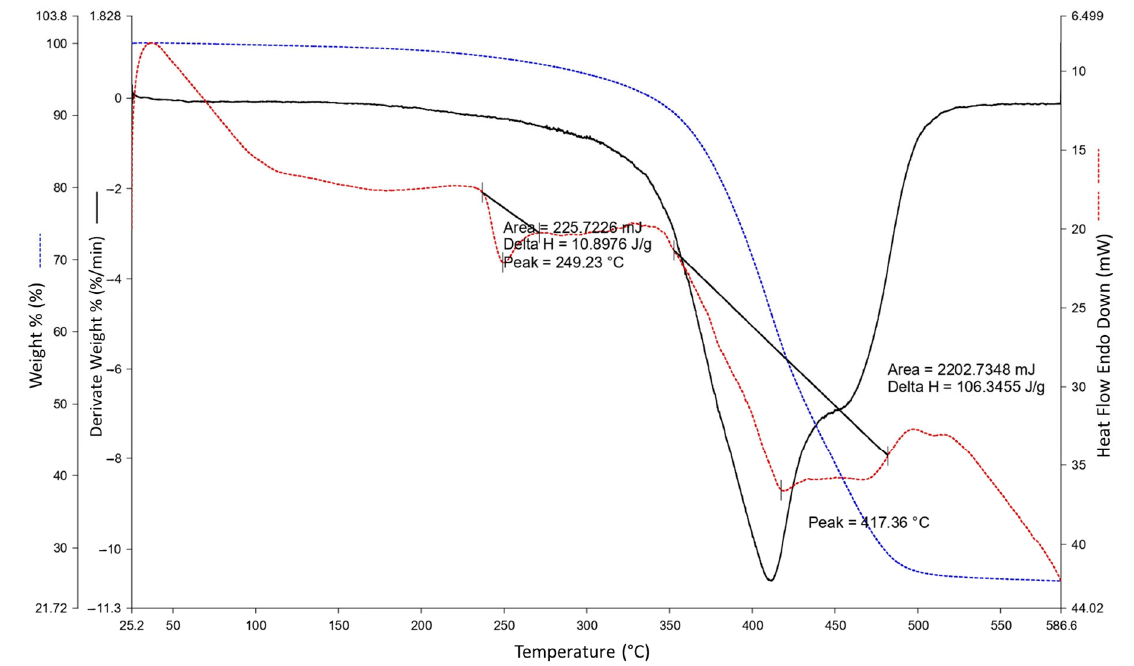
Figure 3. Temperature TGA profile of the WTTF-based additive used in this study.